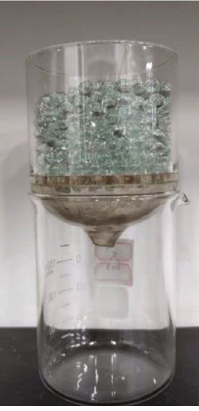
Figure 2: Heavy oil gravity drainage